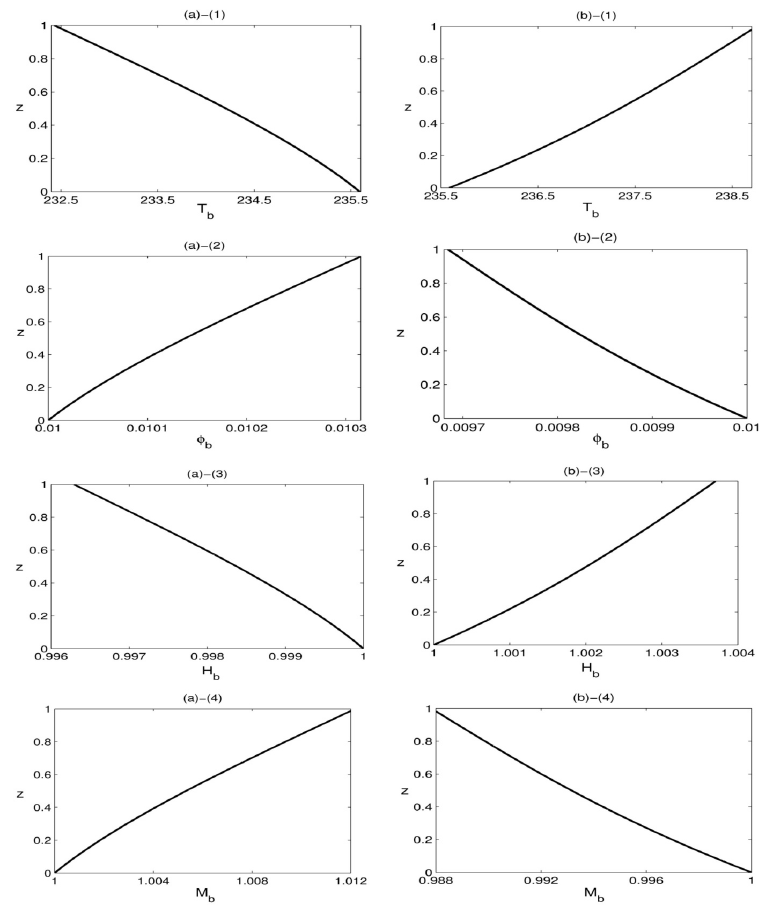
φ (3) H , T (2) , and b b b